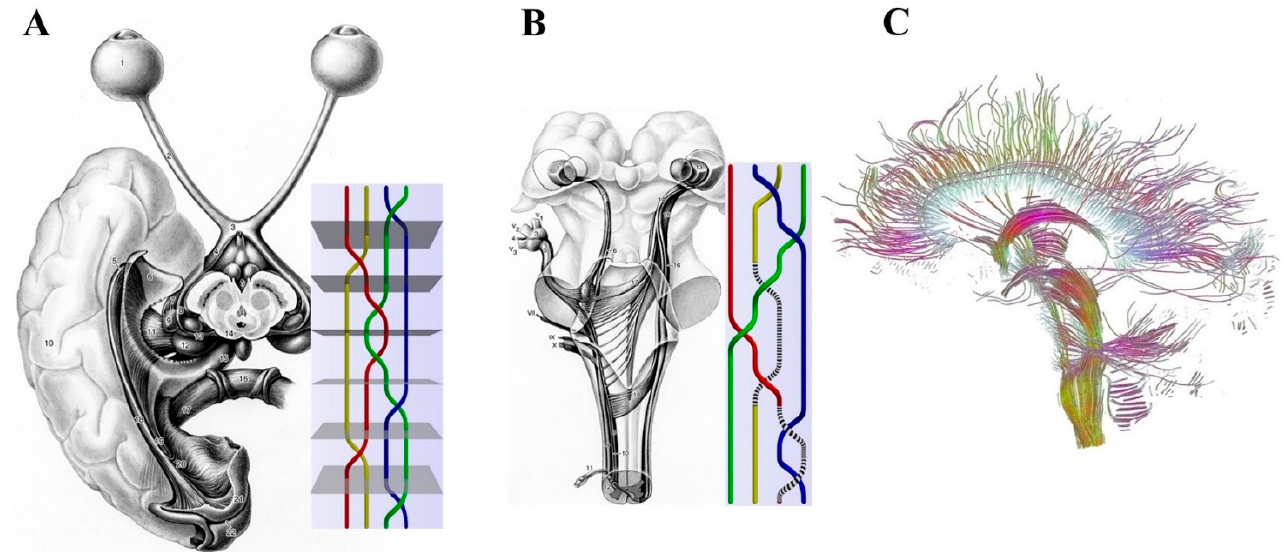
Figure 1. ( A , B ). Comparison of nervous connections in the central/peripheral nervous systems and mathematical examples of braid groups. The figures illustrate the retino–geniculo–cortical projection in a ventral view ( A ), the central connections of the trigeminal nerve in a sagittal view ( B ) and their hypothetical braid counterparts. Modified from: [31] For further details, see [32]. ( C) . The anatomical nervous structures detectable by tractography can be described in terms of braids. Modified